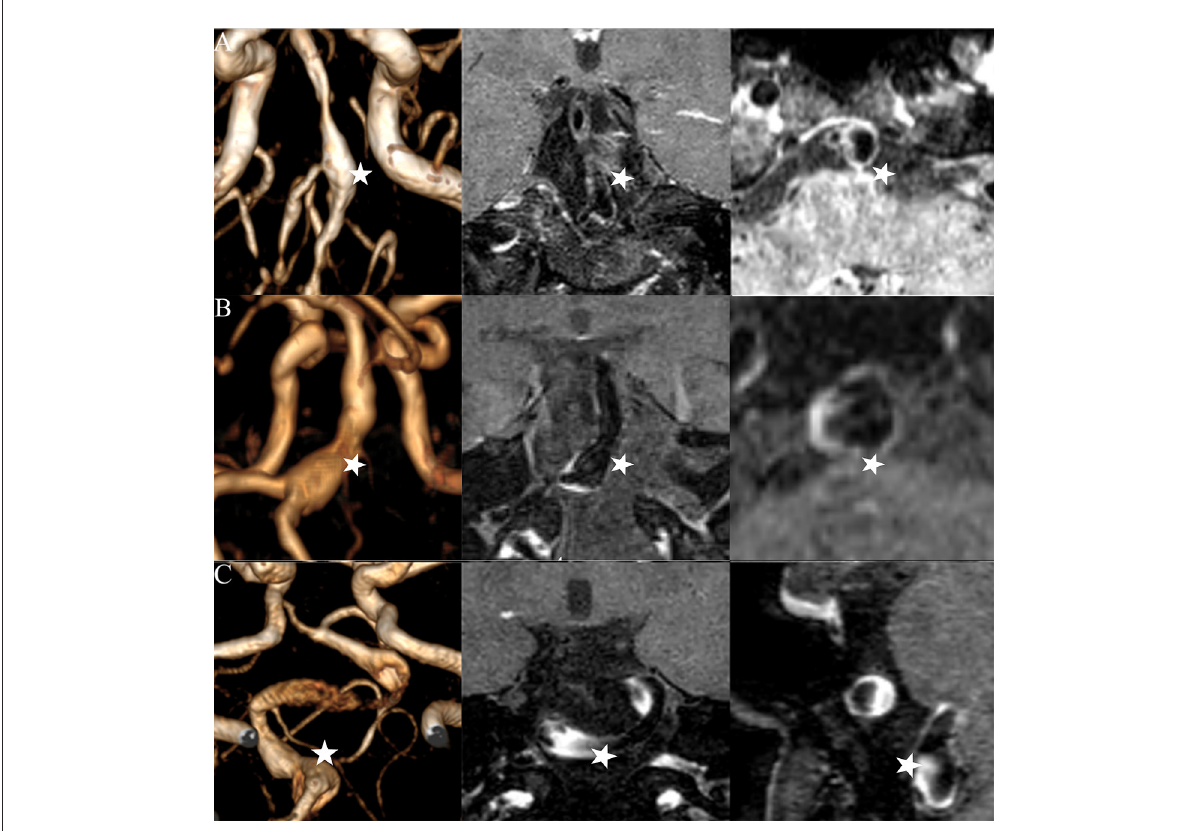
FIGURE1 Three types of FIAs: fusiform (A) , dolichoectatic (B) , and transitional (C) . Time-of-flight MR images (left column), post-contrast high-resolution MR images in the long-axis of the FIAs (middle column), and post-contrast high-resolution MR images in the cross-section of the FIAs (right column) are illustrated by each IFA